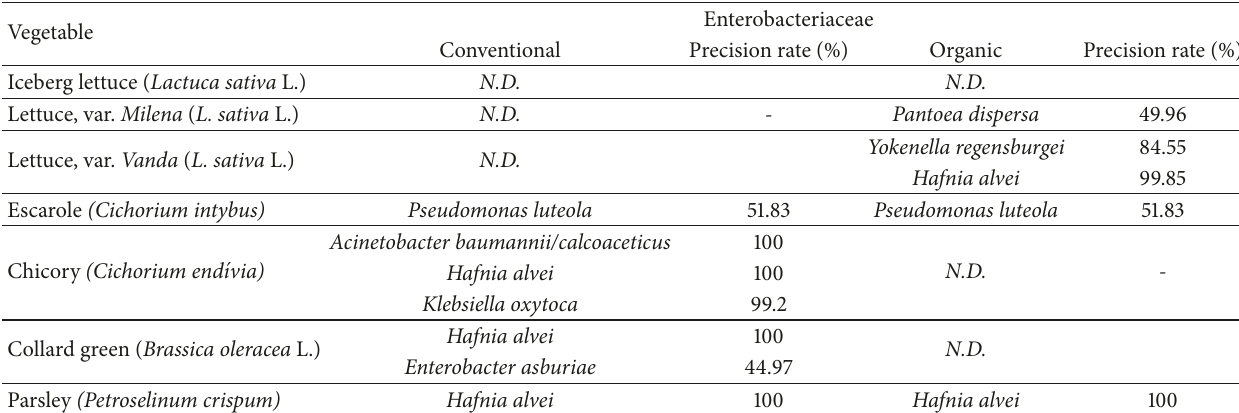
Table 3: Enterobacteriaceae species identified by miniature kits Bactray I and II from samples of organic and conventional cultivation of leafy vegetables. Vegetable Iceberg lettuce ( Lactuca sativa L.) Lettuce, var. Milena ( L. sativa